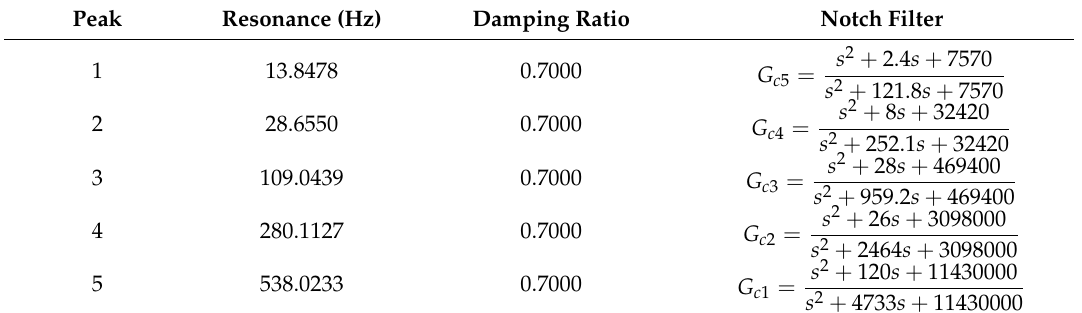
Table 3. Notch filter design.